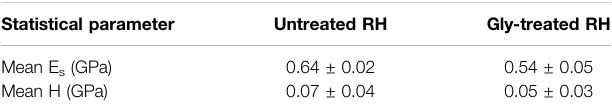
TABLE 1 | Average elastic modulus (E) and hardness (H) of untreated and treated RH along with the standard deviations. Statistical